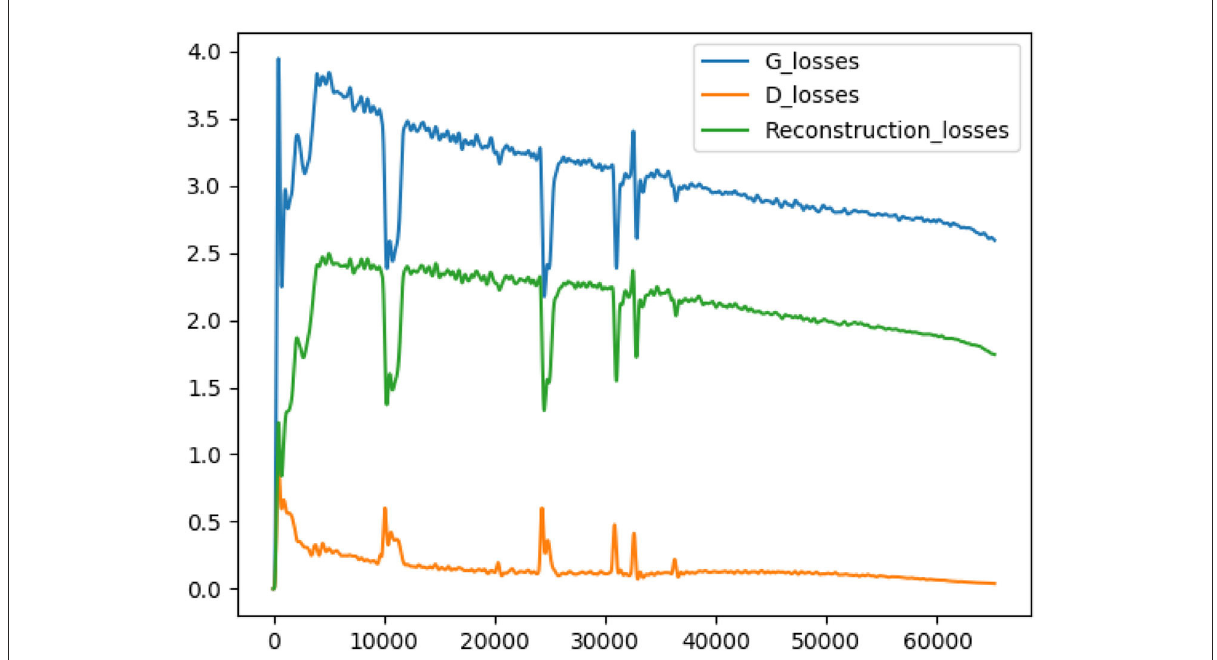
FIGURE4 The blue line represents the generator loss, the yellow line represents the discriminator loss, and the green line represents the reconstructed